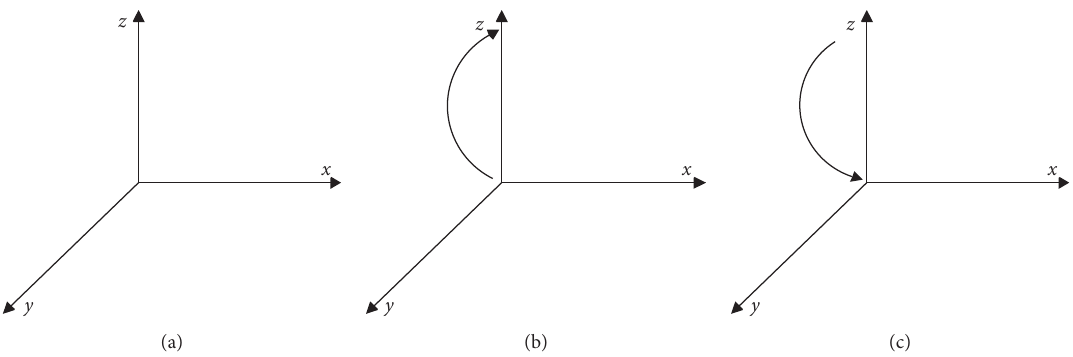
Figure 4: Dynamic phase diagram of local people strategy selection stability evolution and replication.